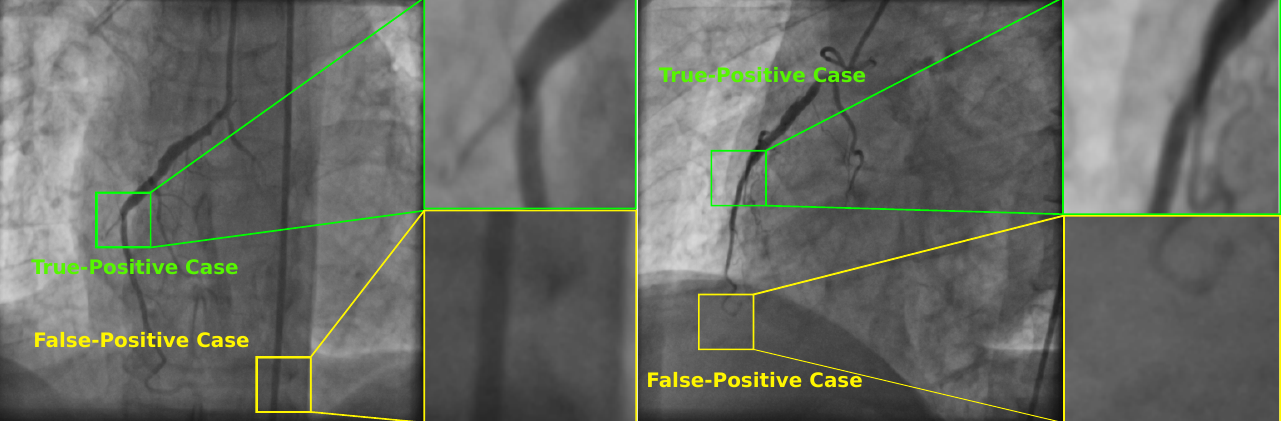
Figure 5. Selected X-ray angiograms with True-Positive and False-Positive stenosis cases detected by the SVM-based classifier using the set with 20 features found by UMDA.